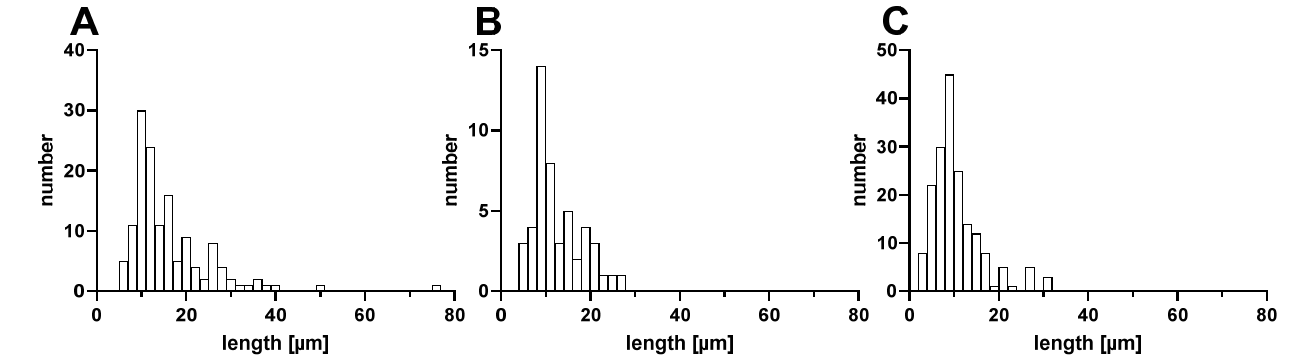
Figure 2. Fiber length distribution of ( A ) PES, ( B ) PAN, and ( C ) PA6 microfibers as determined by SEM analysis.